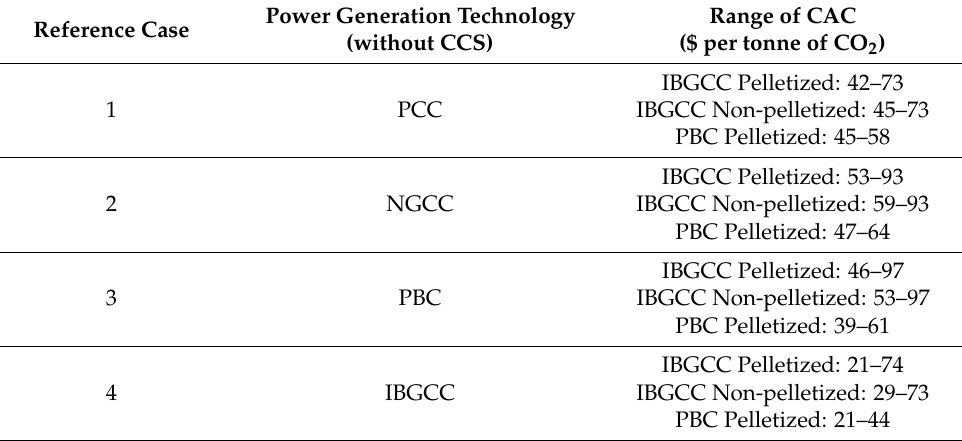
Table 4. Tabulated ranges of calculated CAC for different power plant reference cases.